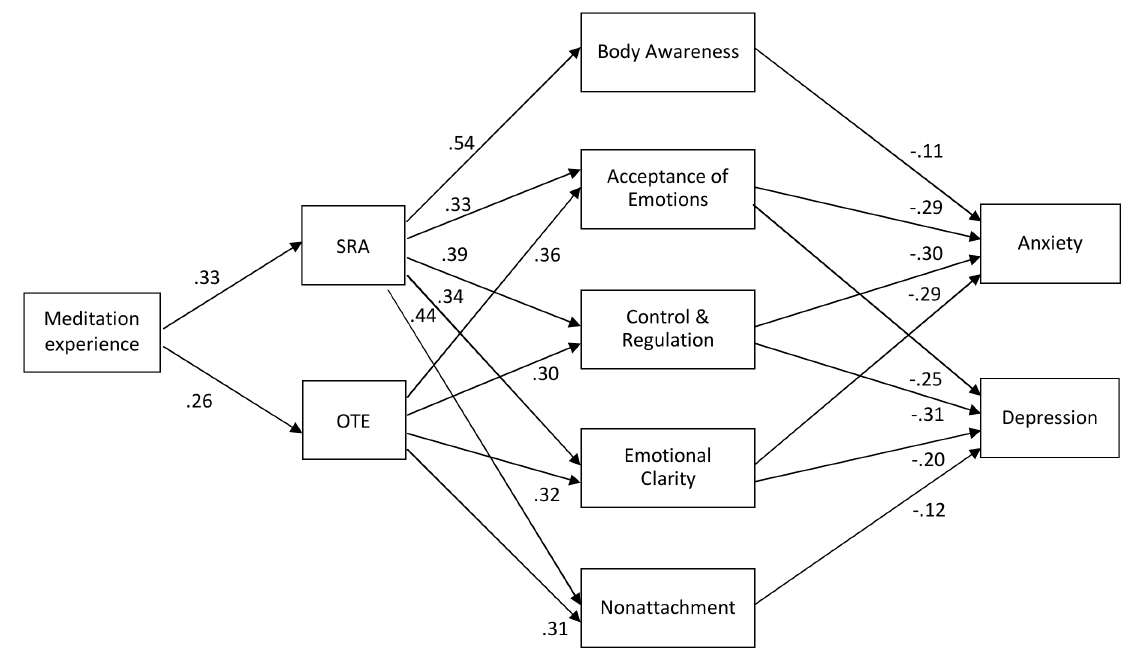
Figure 3. Path model on the effects of meditation experience on mindfulness, mechanisms of mindfulness, and depression and anxiety in the Spanish data. Numbers are standardized path coefficients. SRA = Self-regulated Attention; OTE = Orientation to Experience. Self- regulated Attention and Orientation to experience were allowed to correlate, as were mechanisms, and depression and anxiety. All p s , .015.